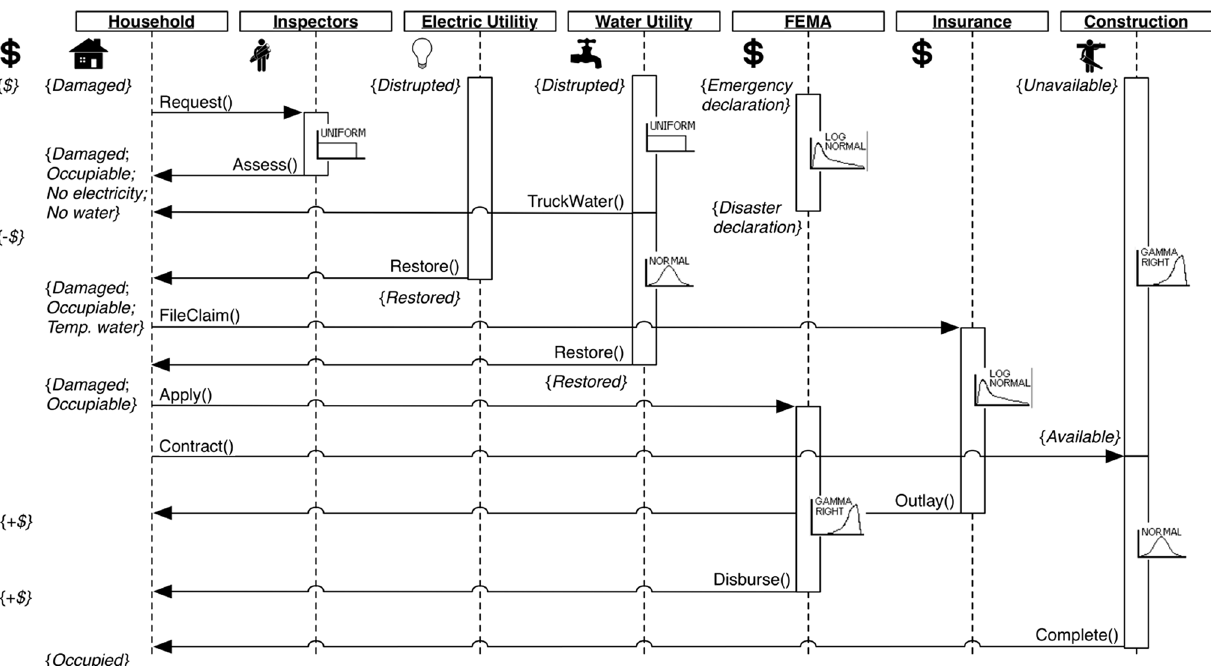
represent shared resources, with states indicated in curly brackets {}. This illustration does not include all possible recovery entities, resources, and processes for housing or household recovery